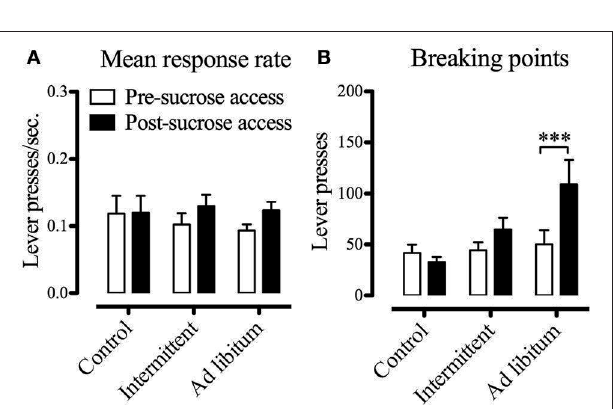
FIGURE 7 | Mean response rate (A) and breaking points (B) of animals before and after the 28-day protocol ( n = 5 each group, control, intermittent, and ad libitum ). Data expressed as means ± S.E.M. *** p < 0.001 pre-sucrose access vs. post-sucrose access, ad libitum